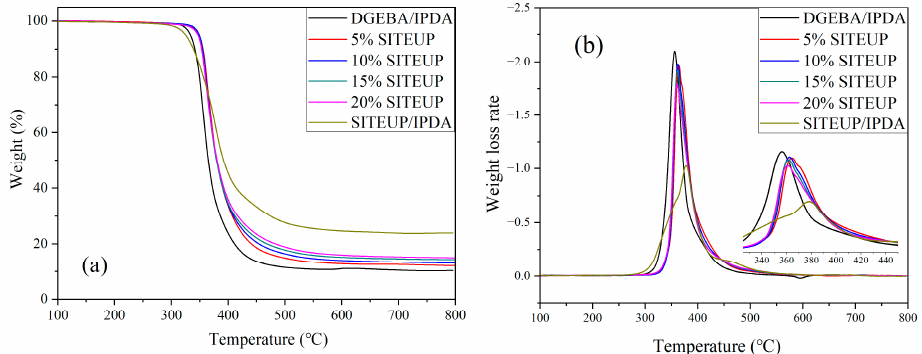
Figure 8. Thermogravimetric analytical curves of DGEBA/IPDA with different content of SITEUP. ( a ) TG thermographs; ( b ) DTG curves. Table 2. Thermal stability parameters of the cured epoxy thermosets with different contents of SITEUP. Sample